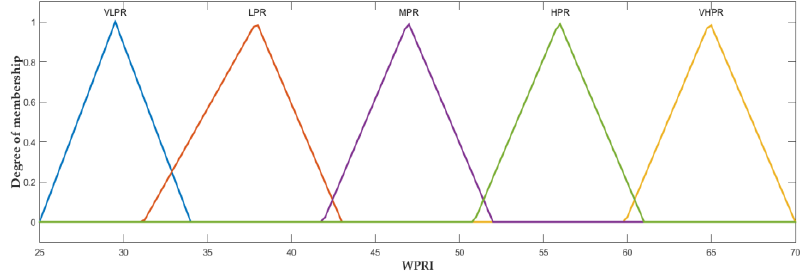
Figure 8. MFs for the output variable of